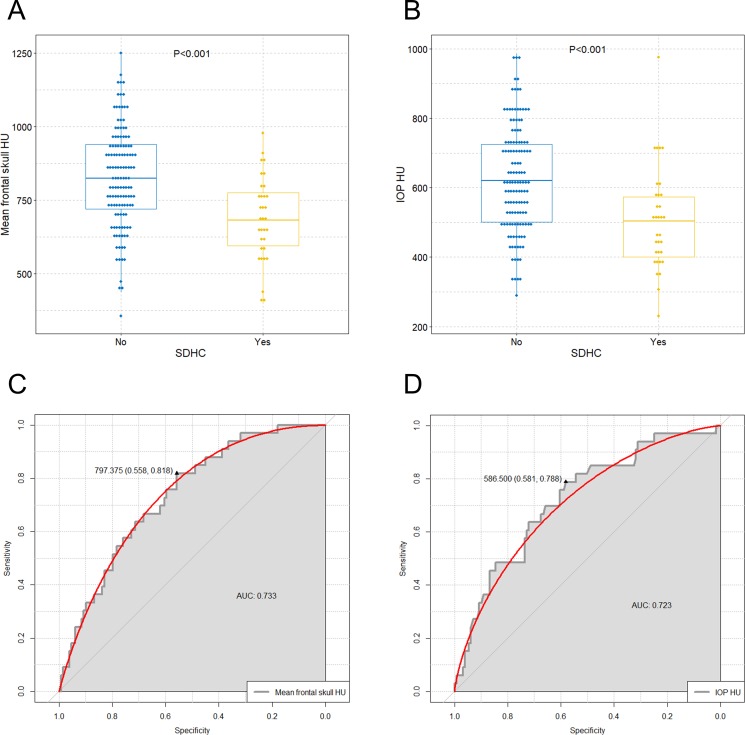
Comparison of mean frontal skull HU and IOP HU values between SDHC and non-SDHC groups and determination of the optimal cut-off skull HU values for prediction of SDHC after DC for traumatic acute SDH.Boxplots with dot plots of (A) mean frontal skull HU values and (B) IOP HU values according to SDHC. ROC curve to identify the optimal cutoff values of (C) mean frontal skull HU values and (D) IOP HU values for prediction of SDHC. HU = Hounsfield unit; IOP = internal occipital protuberance; SDHC = shunt-dependent hydrocephalus; DC = decompressive craniectomy; SDH = subdural hematoma; ROC = receiver operating characteristic; AUC = area under the curve.